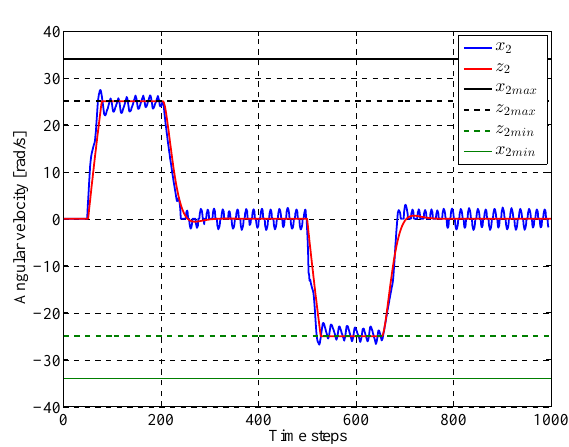
Figure 8: Nominal MPC component of the proposed control